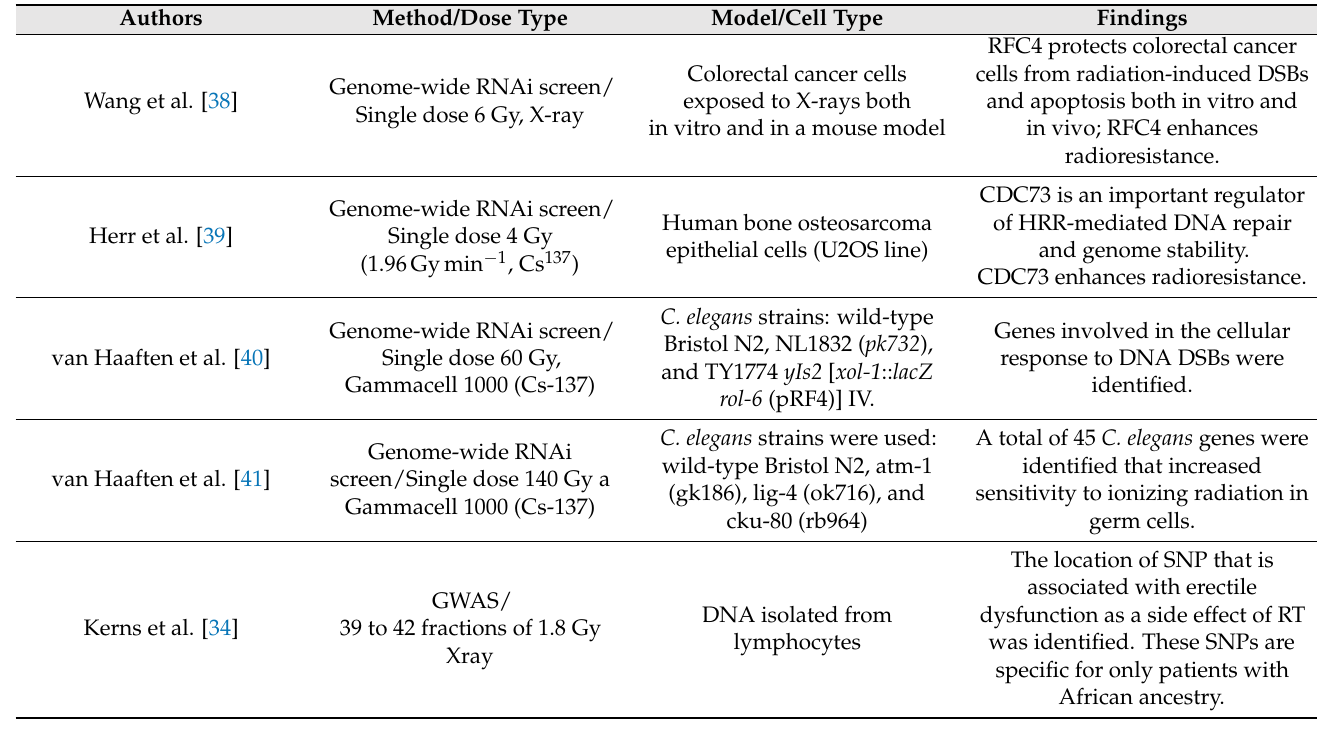
Table 1. Summary of selected current research on radiation